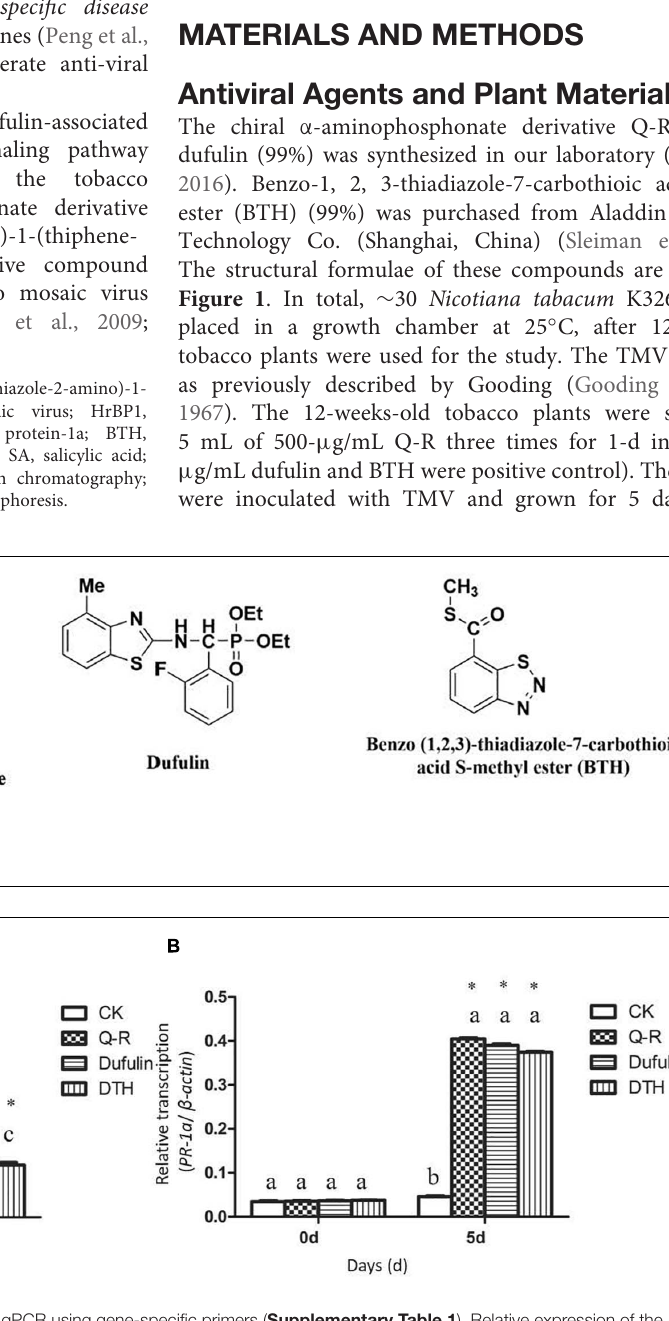
Frontiers in Microbiology |